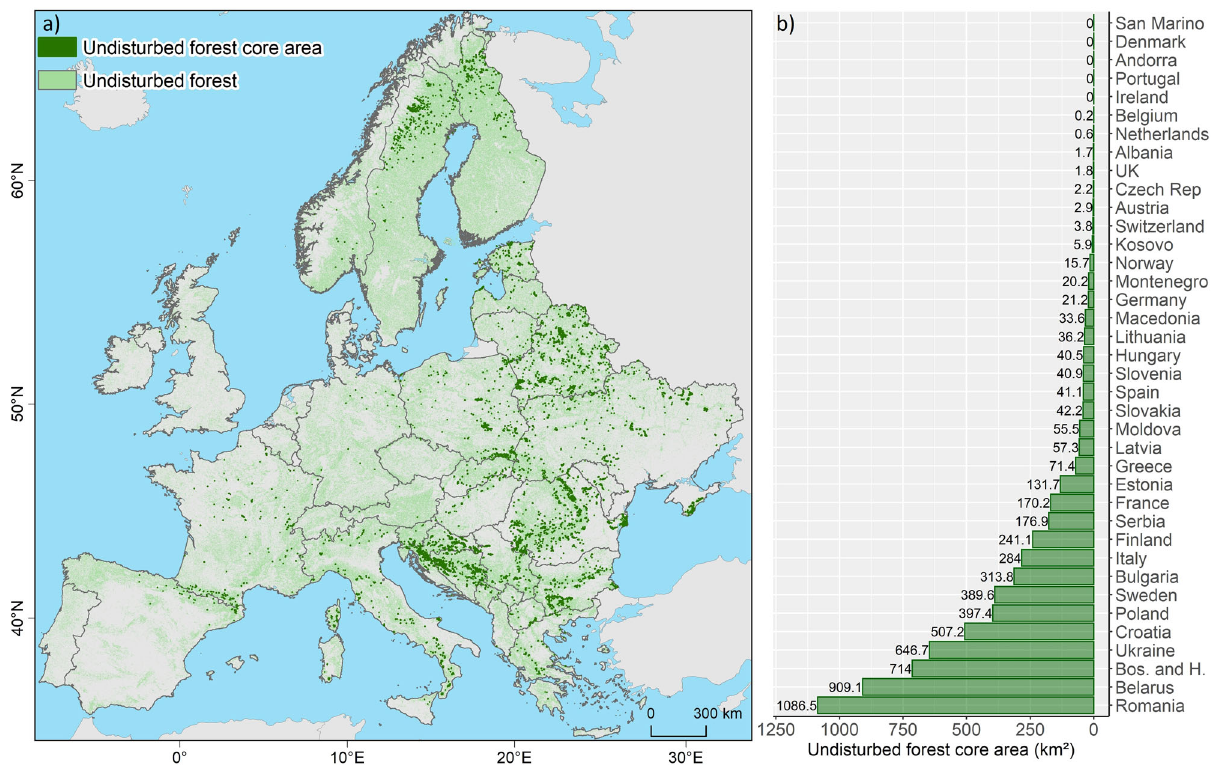
Fig. 1 Undisturbed forest cover and undisturbed forest core areas. a Spatial distributions of undisturbed forest cover and undisturbed forest core areas in 2020. b Undisturbed forest core area size by country in 2020. Forest core areas were >500 m from the edge of the undisturbed forest patches. Borders of the forest core areas have been exaggerated for